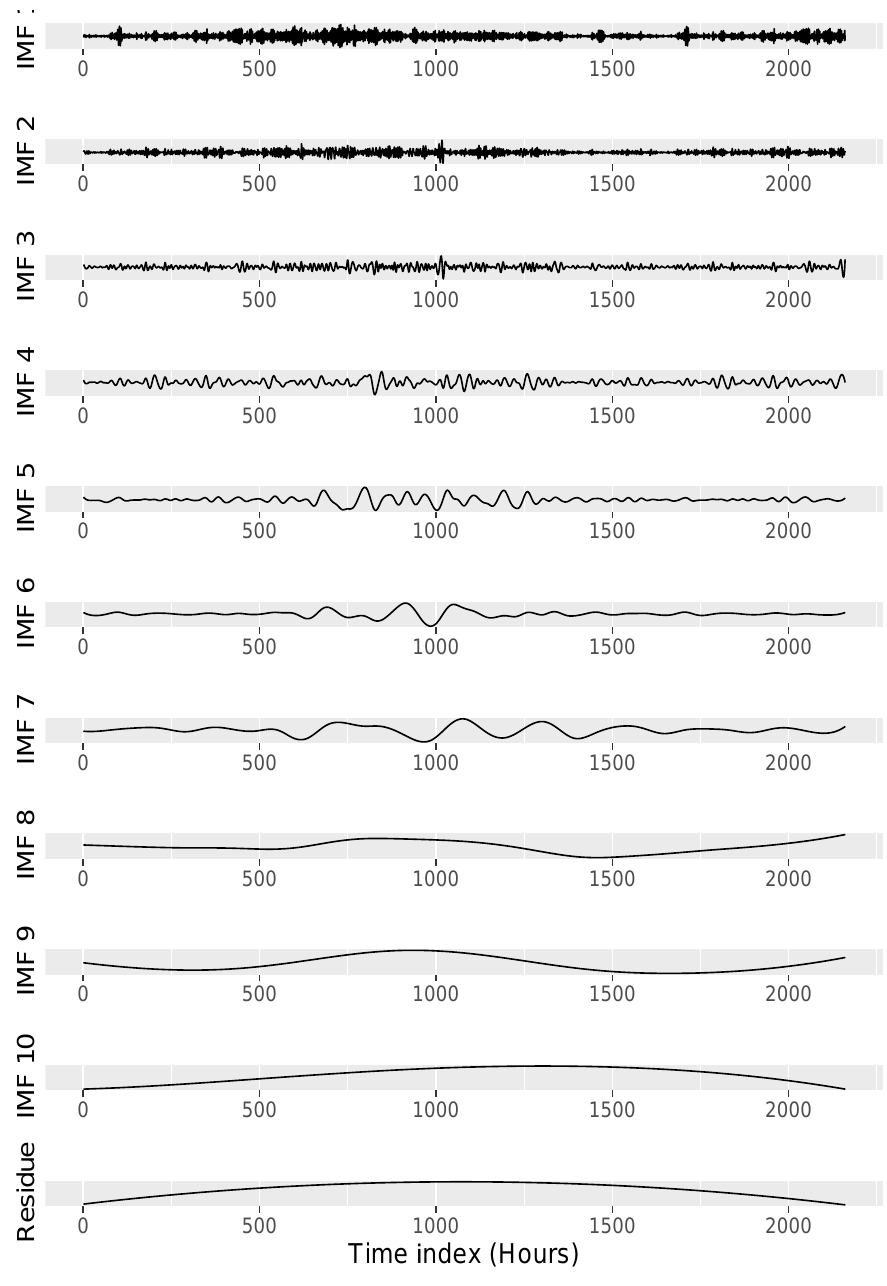
Figure 5. The decomposition of mean hourly Wind power time-series by EEMD method. In the EEMD-PSF model, all sub-series (IMFs and a residue) are forecasted using PSF methodology. First of all, suitable values of clusters and window size are calculated for all IMFs, shown in Table 2. With respect to these parameters, different PSF models are assigned for distinct IMFs and finally, the future values predicted for the desired duration. The aggregation of these predicted values corresponding to all IMFs series is treated as the prediction with EEMD-PSF